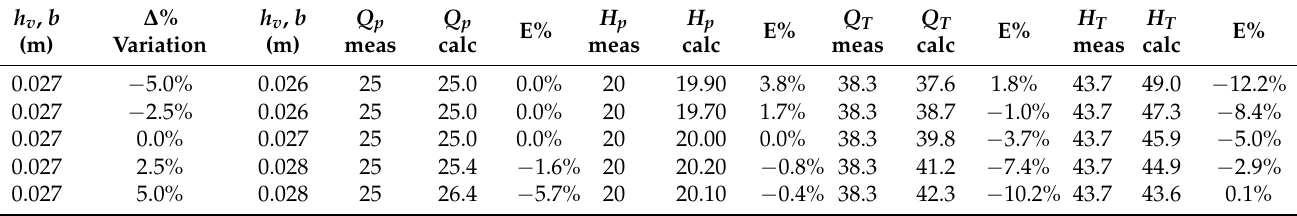
Table 9. Sensitivity analysis for pump 40-250.